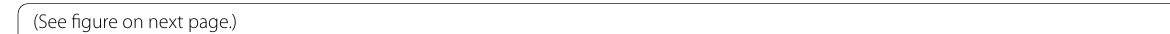
PlGF vector, + 400). × standard deviation. * p < 0.05 vs. ± PlGF. An independent sample t ‑test was used for +